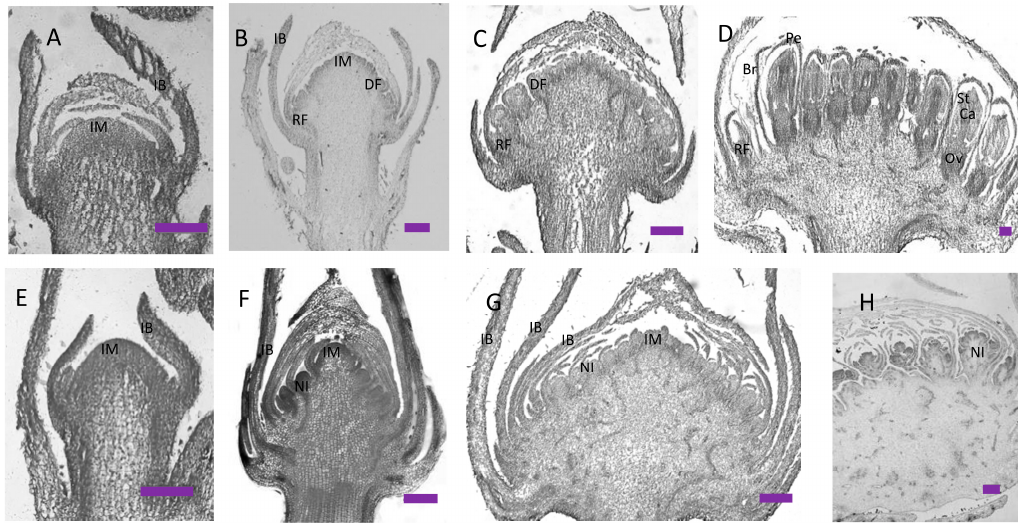
Figure 3. Histological staining of wild-type cosmos ( A – D ) and gh cosmos ( E – H ). ( A ) Young inflorescence meristem in wild-type cosmos; ( B ) the inflorescence meristem transforming into flower meristem in wild-type cosmos; ( C ) most flower meristem was formed in wild-type cosmos. ( D ) flower organs were formed in wild-type cosmos. ( E ) Young inflorescence meristem in gh cosmos; ( F ) ectopic bracts and new inflorescence meristems were formed in gh cosmos; ( G ) more new inflorescence meristems were formed in gh cosmos; ( H ) the inflorescence meristems produced the secondary inflorescence meristems in gh cosmos. IM, inflorescence meristem; IB, Involucral bract; DF, disc flower meristem; RF, ray flower meristem; Br, bract; Pe, petal; St, stamen; Ca, carpel; Ov, ovary; scale bars = 200 μ m.